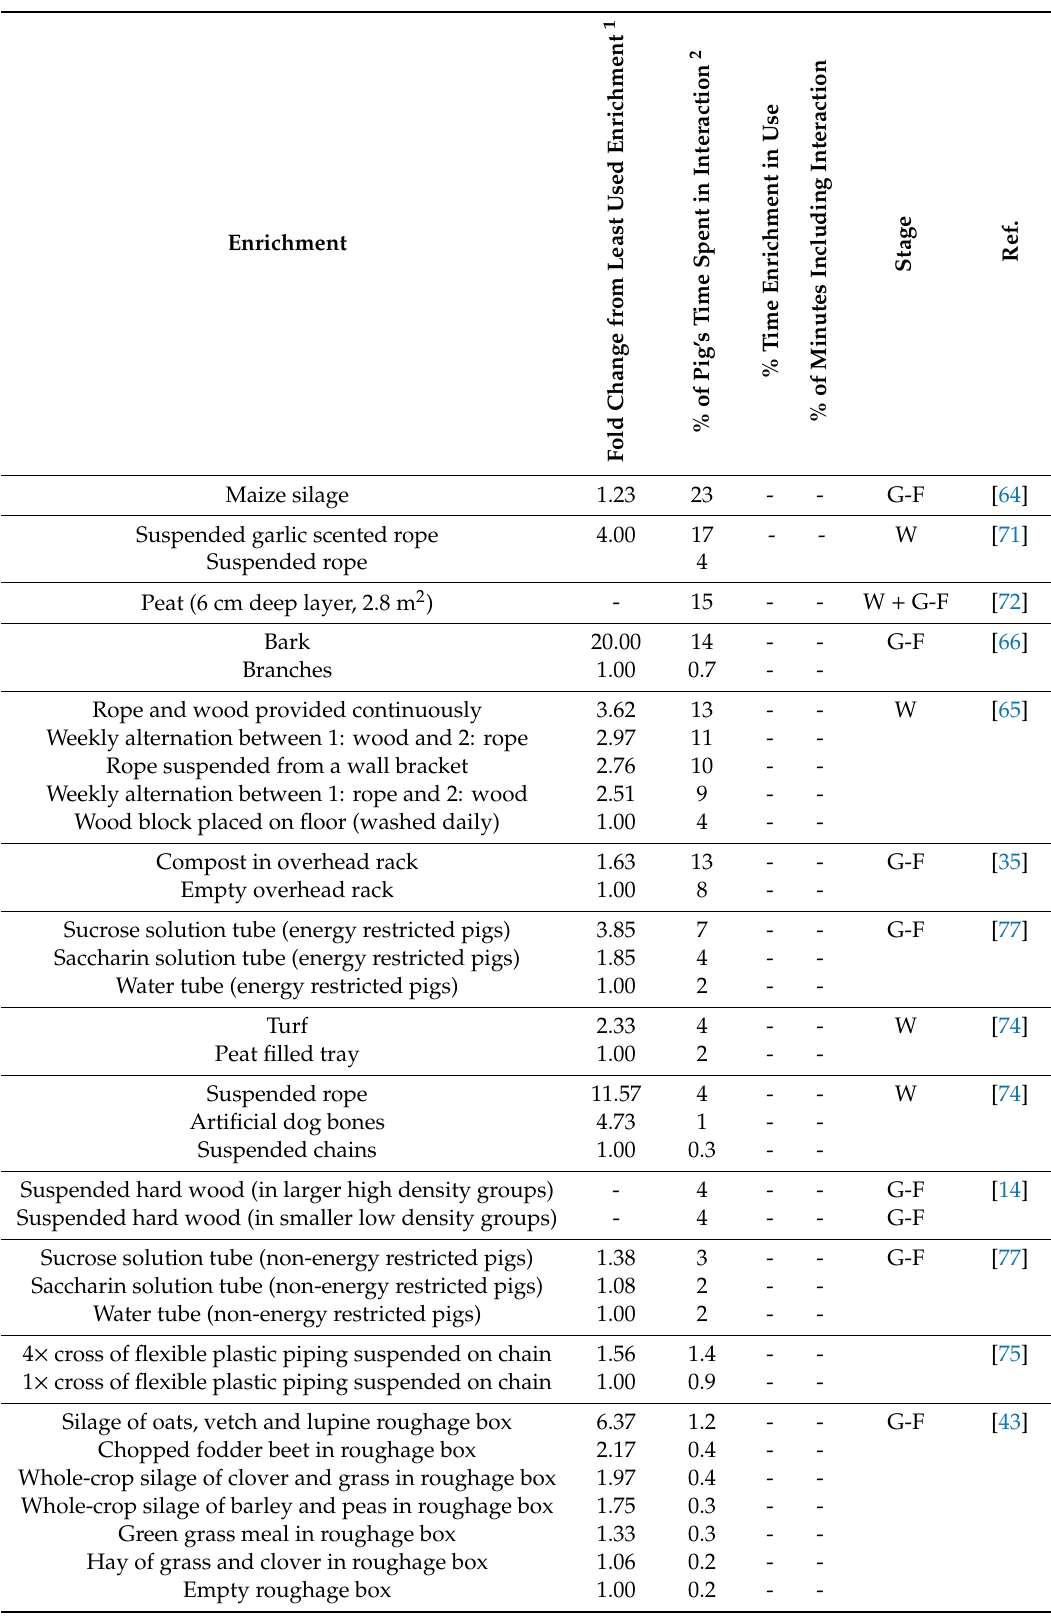
Table 3. Interaction with di ff erent types of enrichment compared within one